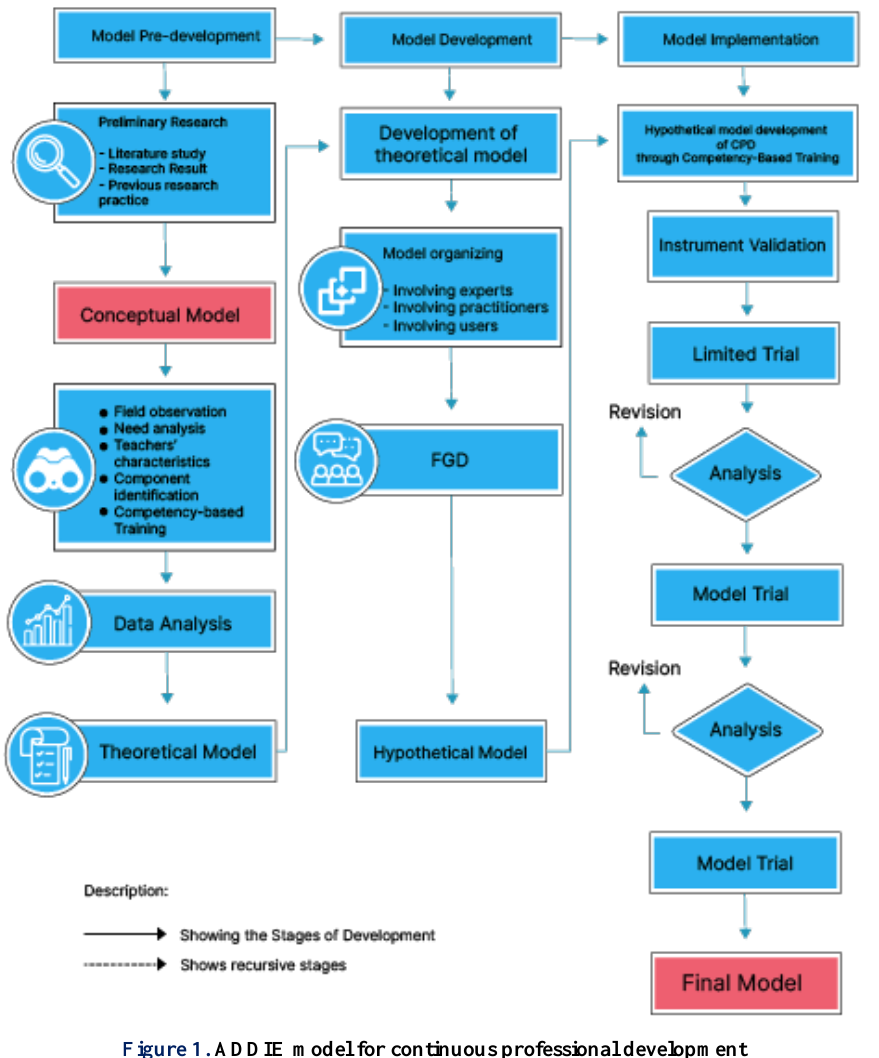
Figure 1. ADDIE model for continuous professional